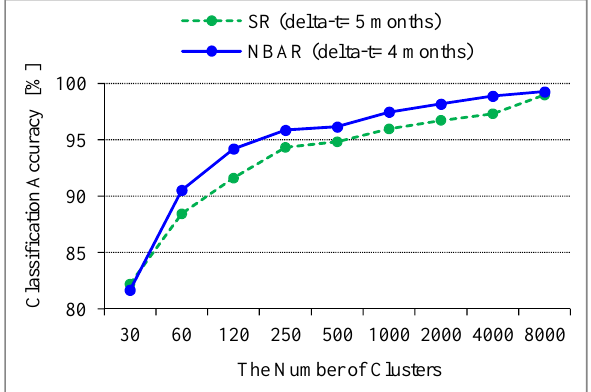
Figure 8. The relationship between the number of clusters and classification accuracies obtained by time-domain co-occurrence matrix which is defined with spectral